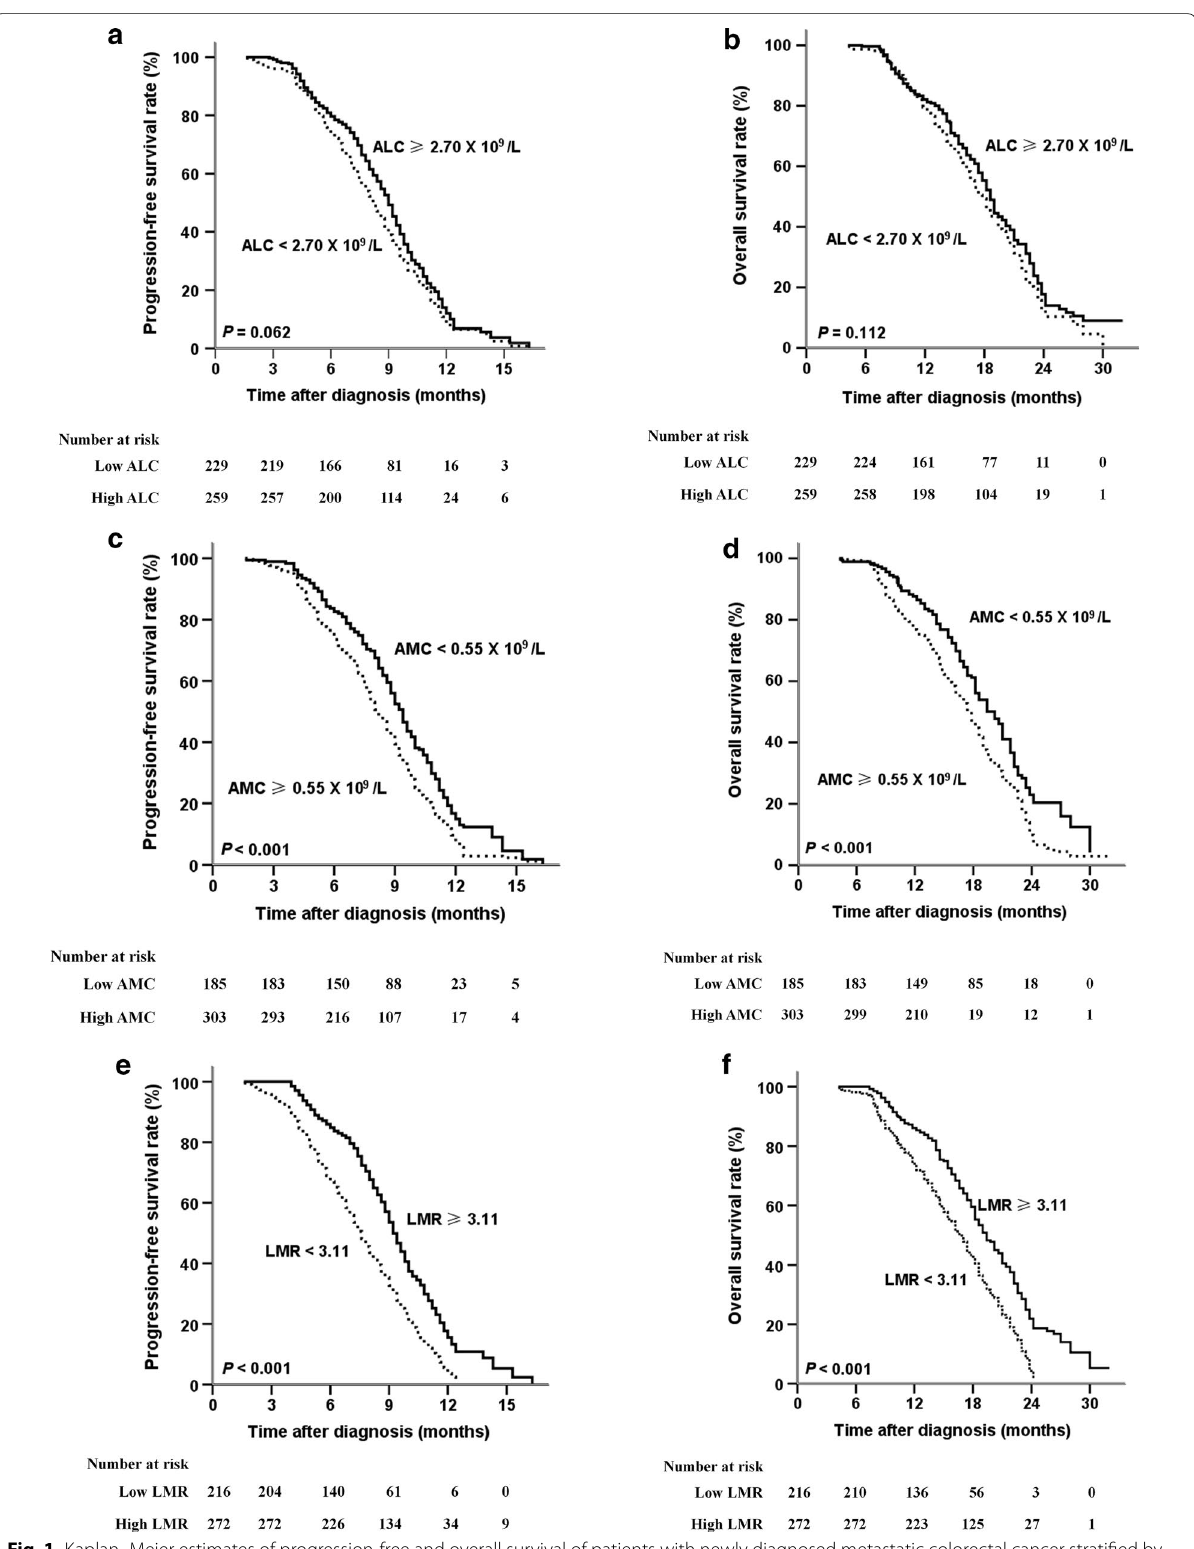
Fig. 1 Kaplan–Meier estimates of progression‑free and overall survival of patients with newly diagnosed metastatic colorectal cancer stratified by pre‑treatment ALC ( a , b ), AMC ( c , d ), and LMR ( e , f ). ALC absolute lymphocyte count, AMC absolute monocyte count, LMR lymphocyte‑to‑monocyte